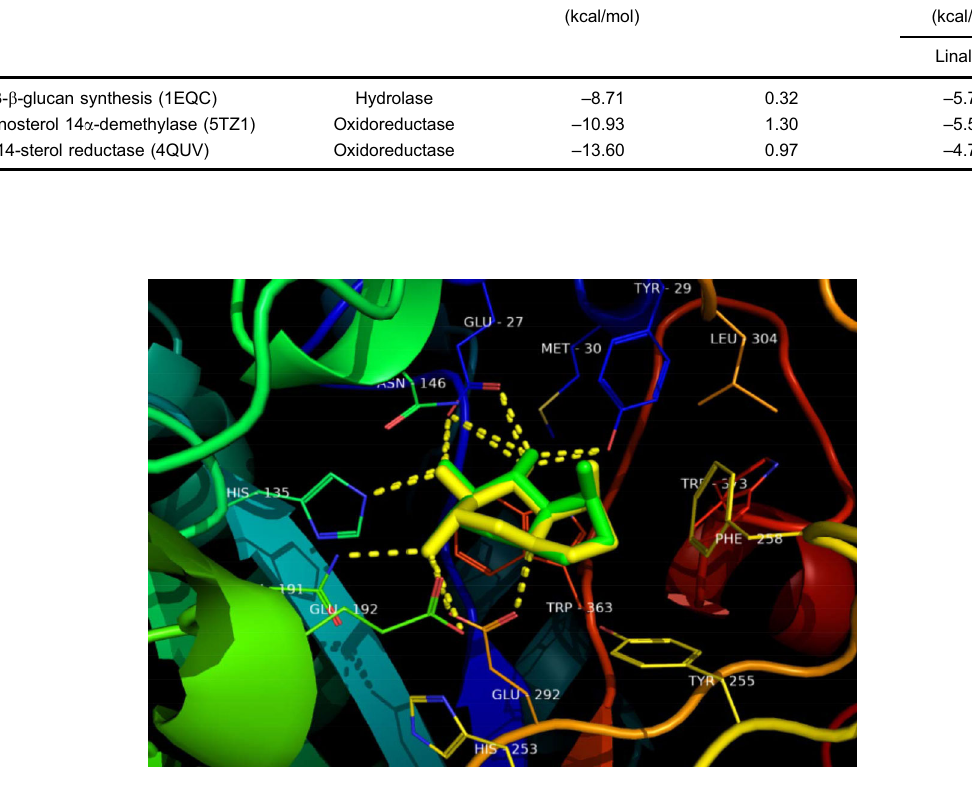
Figure 1. Overlapping castanospermine ligand from 1,3- b -glucan synthase with a better conformation of redocking. Green: Protein Data Bank co-crystal. Yellow: binder conformation after redocking. Dotted yellow: hydrogen-bond